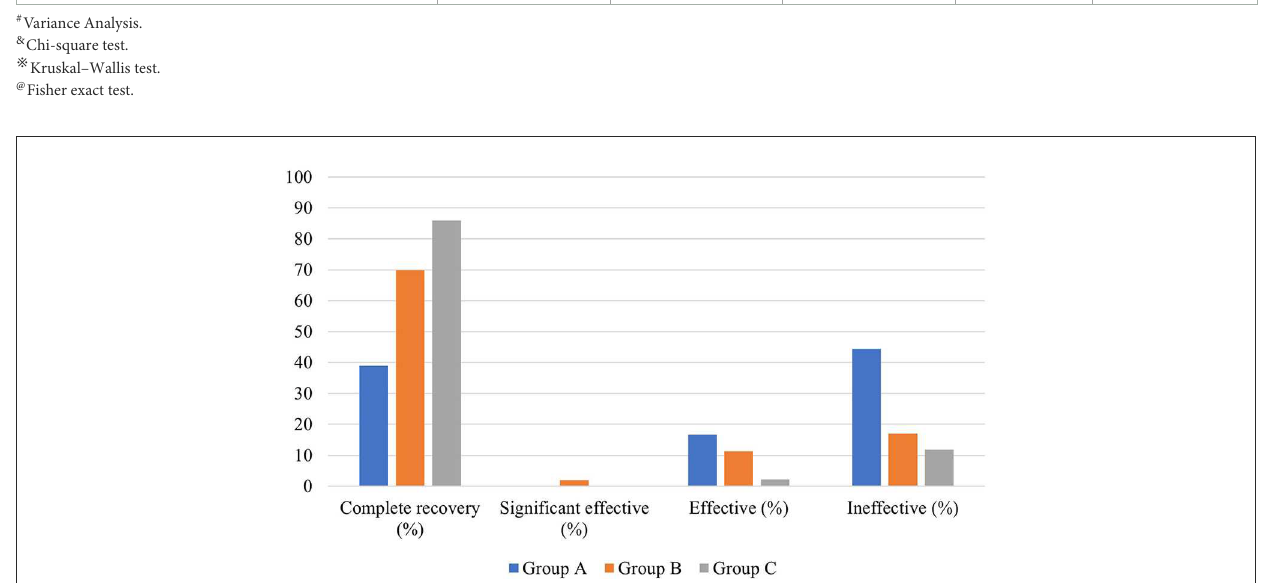
FIGURE5 Hearing efficacy of patients with ascending-type SSNHL in the three groups.